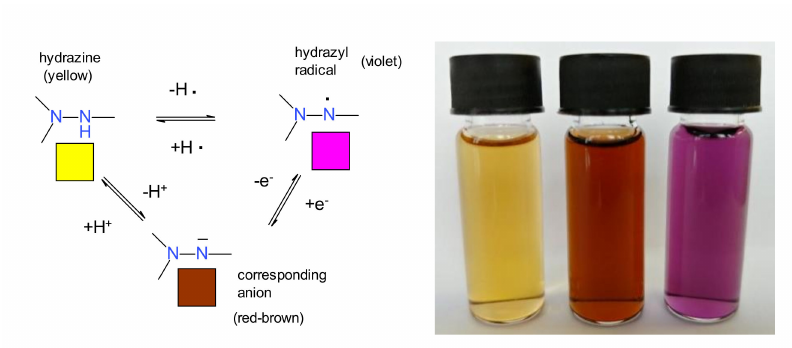
Figure 4. Interconversion of the parent hydrazine into a hydrazyl free radical (by oxidation) or a salt (by reaction with a